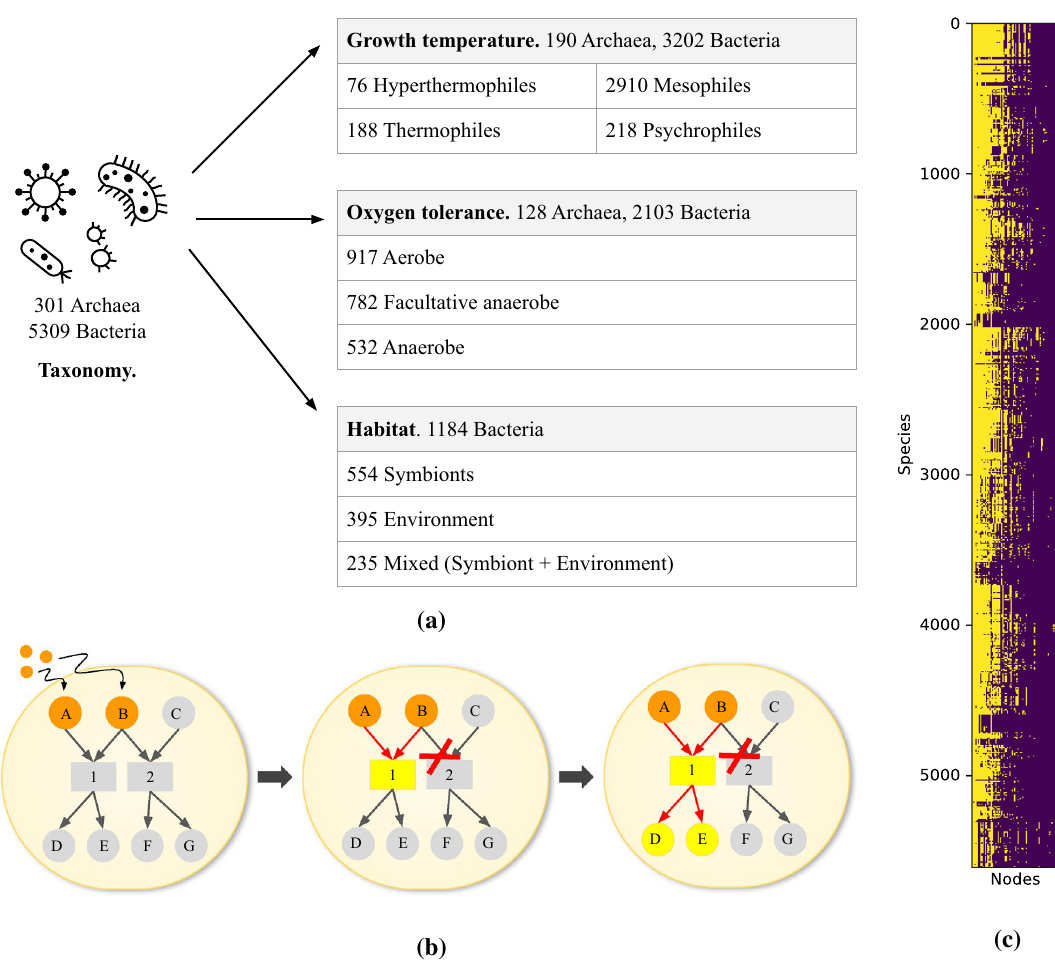
Figure 1. ( a ) Data description. ( b ) Concept of scope of a metabolic network. Letters are metabolites and numbers are reactions. Starting from seed metabolites (orange), the network expands if the substrates of the reactions are present in the expanding network, thereby producing its products. This is the case for reaction 1, which uses A and B to produce D and E, but not for reaction 2, as C is missing. The scope of the metabolic network is the set of all metabolites and reactions in the resulting network (yellow and orange). ( c ) Matrix of nodes in scope per species. In yellow, nodes that are in the scope, in purple the nodes that are out of the scope. Nodes that are in or out of the scope for all species have been removed. Species are sorted in taxonomic order, and 578 nodes are sorted by number of species with node in the